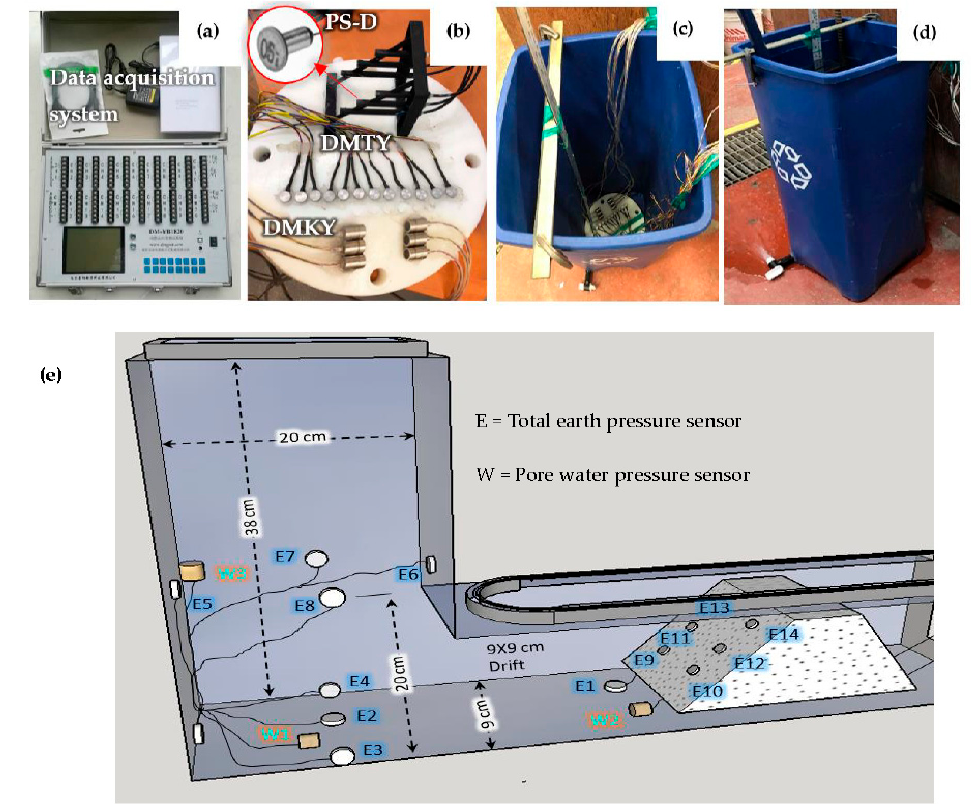
Figure 2. Experimental protocol and arrangement: ( a ) strain gauge data acquisition system (20 channels), ( b ) all pressure sensors used are installed on a plate before calibration, ( c ) pressure sensors attached to a plate at the base of a bucket for the calibration, ( d ) calibration procedure of the pressure sensors using water, and ( e ) dimensions of the model and the different locations of the pressure sensors.